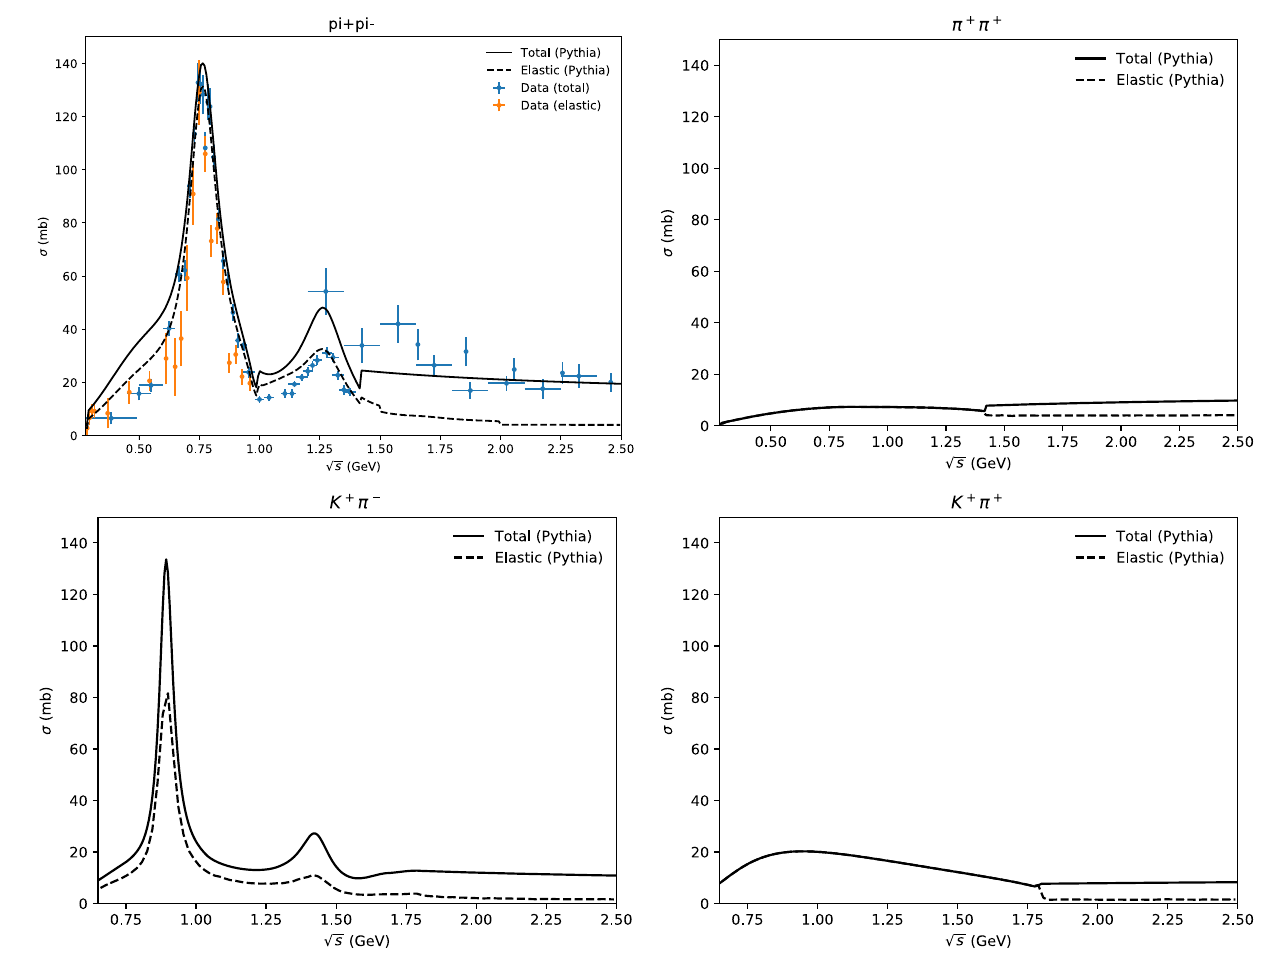
SMASH [36] use a different cross section that more closely matches this data, and this discrepancy may be addressed in future work. Note that in some theory calculations the concept of elastic is extended to related processes, e.g. π + π − → π 0 π 0 may count as part of a broader ππ → ππ “elastic” process. If we had taken that viewpoint, the elastic cross sections for π + π − and K + π − would have equalled the total cross section at low